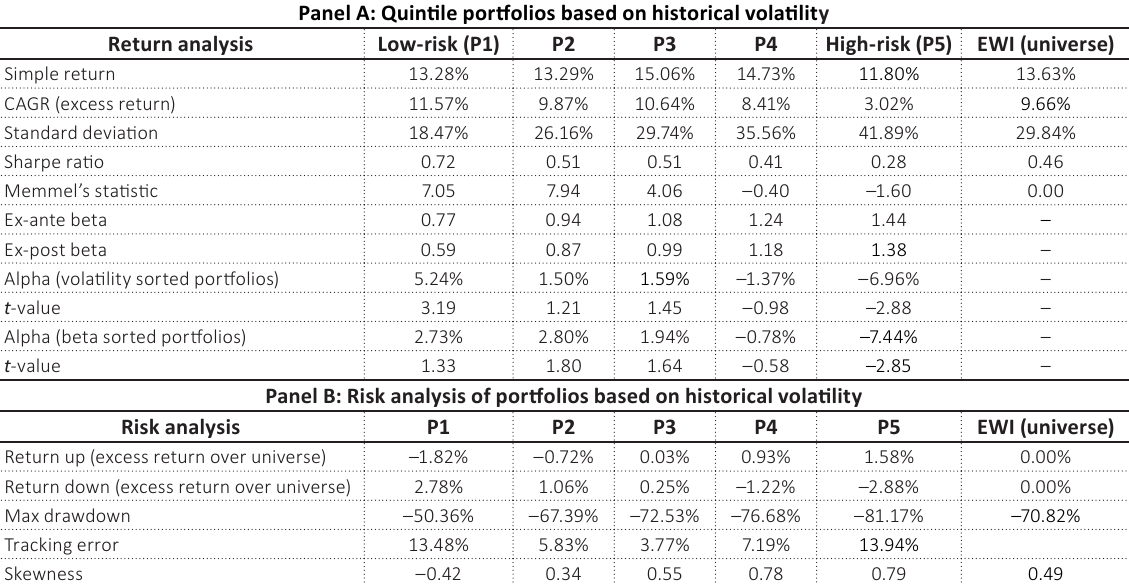
Table 1. Main results (annualized) for quintile portfolios based on historical volatility Panel A: Quintile portfolios based on historical volatilit